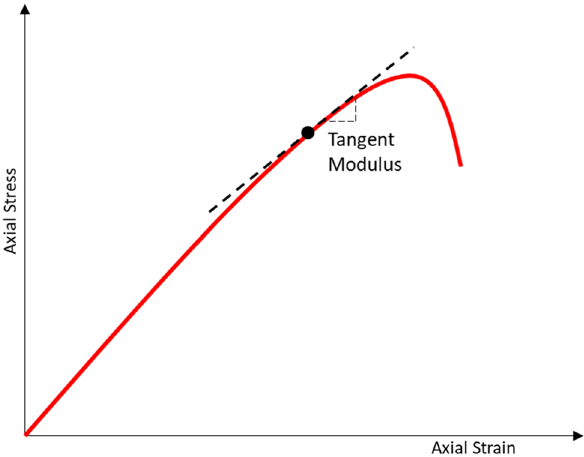
Fig. 2 Schematic of stress strain curve showing Tangent modulus